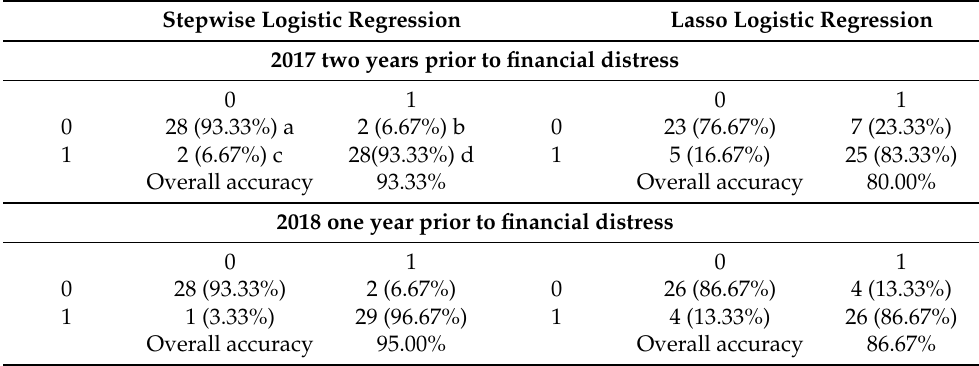
Table 7. Confusion matrices for logit models, years: